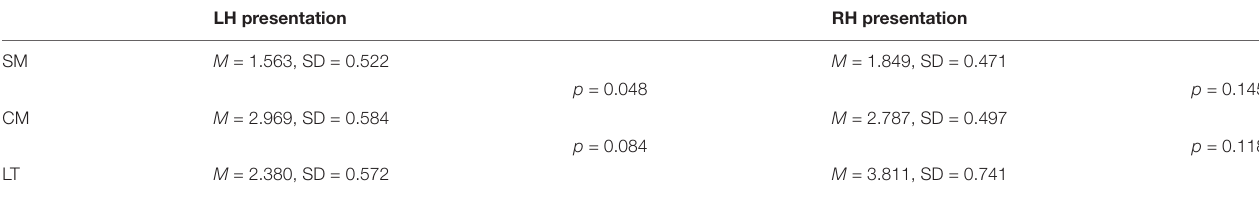
TABLE 4 | Post hoc analysis results of LPCs elicited by the three